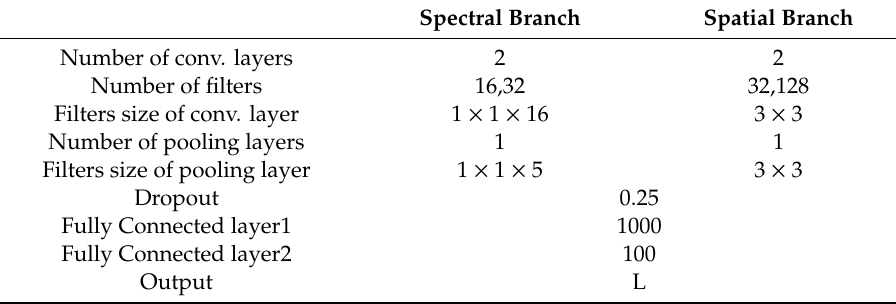
Table 4. Network parameters of TDDA.